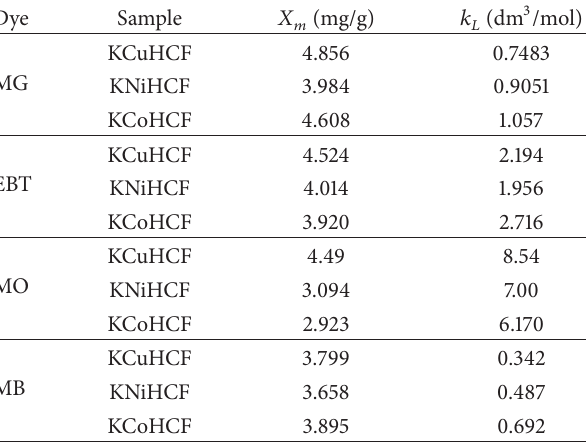
Table 3: Langmuir constants for different dyes adsorption on various KMHCF